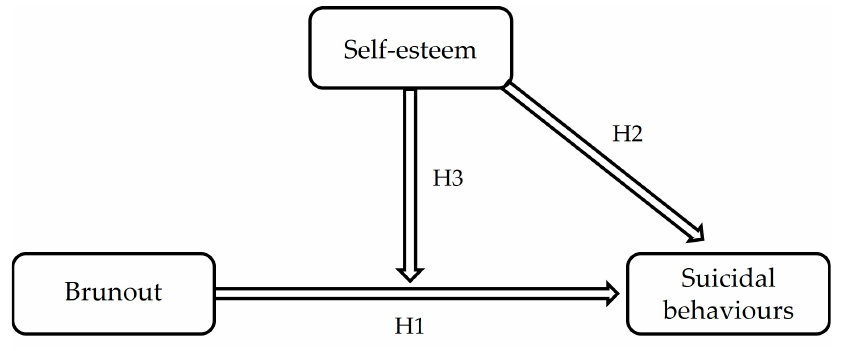
Figure 1. Research Model.